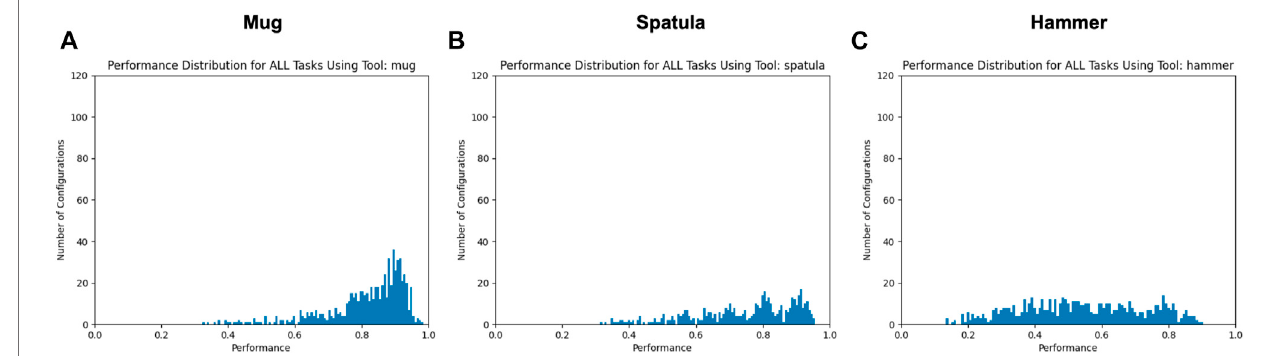
FIGURE6| Meanperformancedistributionsusingeachtoolforalltasks,withalltrialswithmeanperformance ≤ 0.05excluded. X -and Y -axesareconsistentacross all graphs.